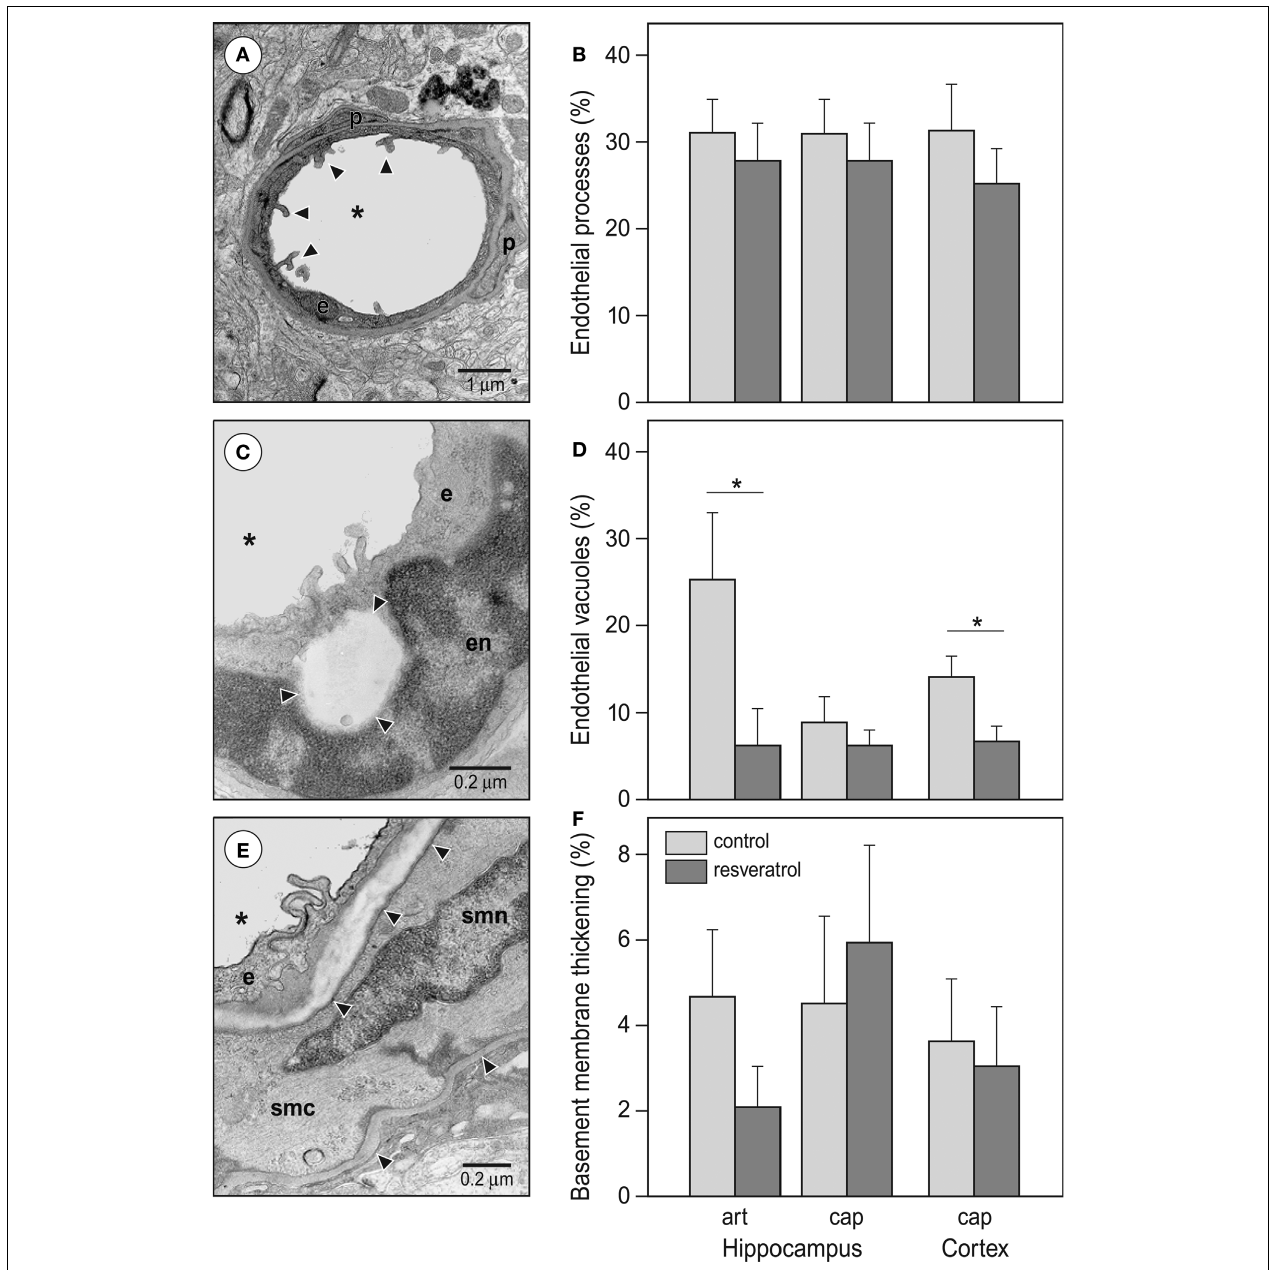
FIGURE 5 | Effects of resveratrol supplementation on the occurrence of microvascular abnormalities. (A) Representative photomicrograph and (B) quantitative analysis of endothelial processes. Arrowheads point at the typical endothelial processes of a cortical capillary. (C) Representative photomicrograph and (D) quantitative analysis of endothelial vacuoles (* p < 0.05). The photomicrograph demonstrates a capillary in the hippocampus CA1 region. Arrowheads are pointing at the large, empty endothelial vacuole.